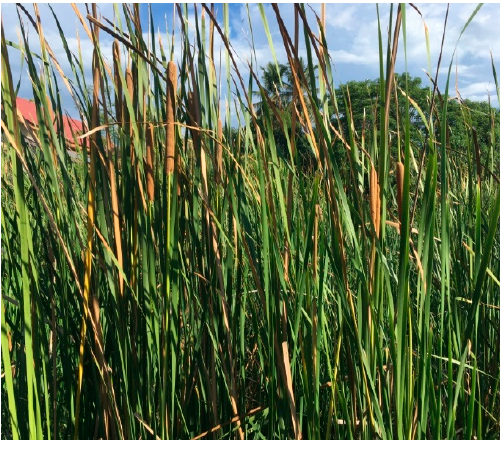
Figure 1. Typha spp. plant.